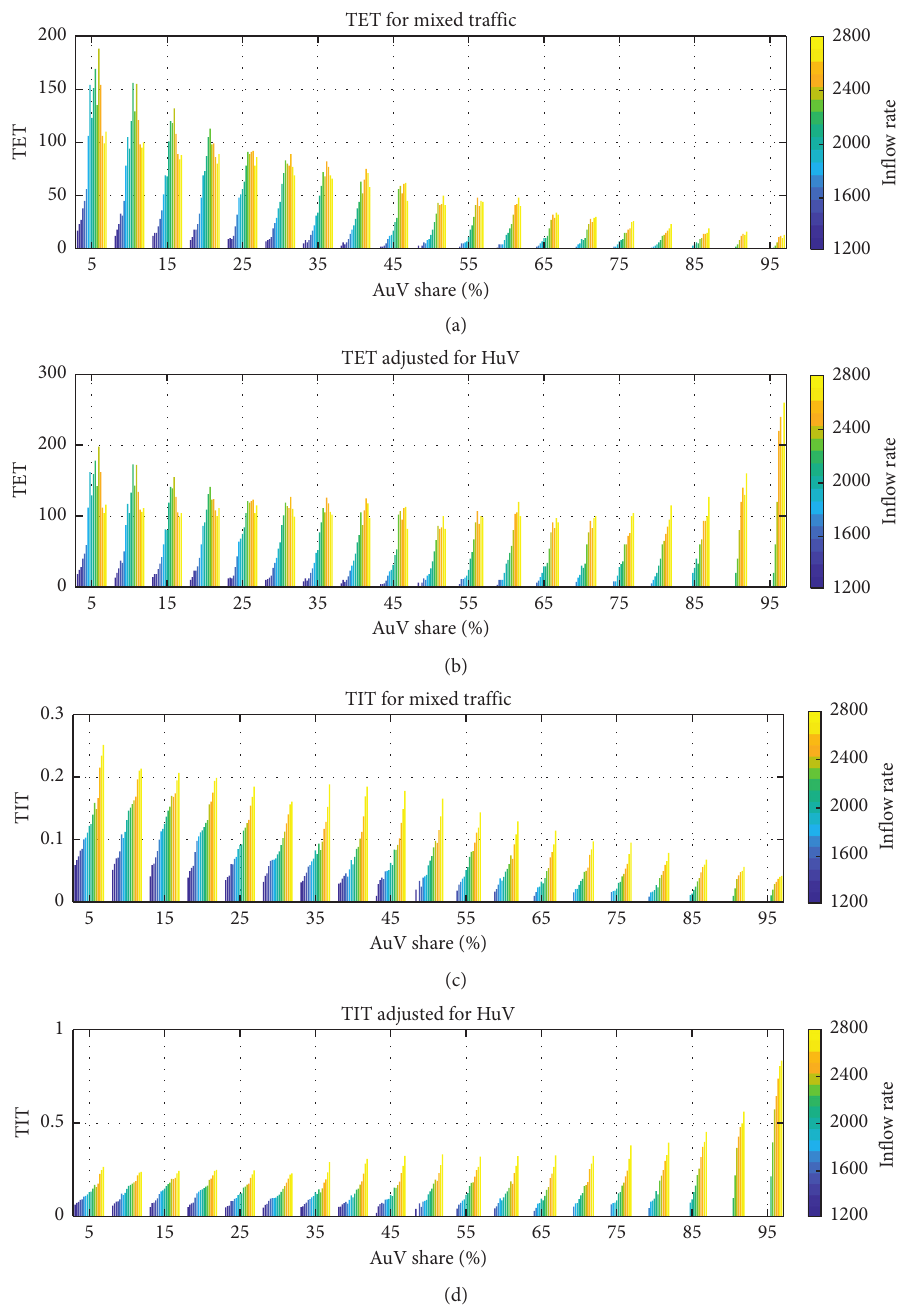
Figure 7: TET and TIT values in different traffic states for (a, c) total traffic and (b, d) HuVs